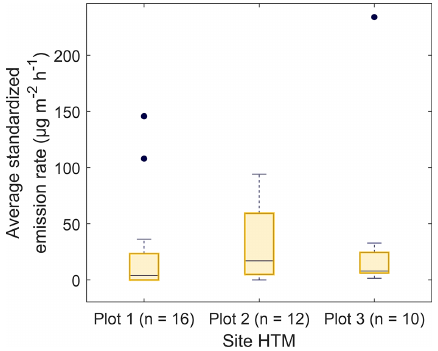
Figure 5. Boxplots of the temperature standardized emission rates of the healthy trees for plots 1–3 in Hyltemossa, where plot 3 is lo- cated furthest away from the station in an older forest stand. The number of samples taken at each plot is indicated by n ; the black dots indicate outliers. The difference in emission rates was tested using a Kruskall–Wallis test (MATLAB R2021a, MathWorks, Inc., MA, USA) and indicated no significant difference for the daily av- erage of the temperature standardized emission rates ( P > 0.3).